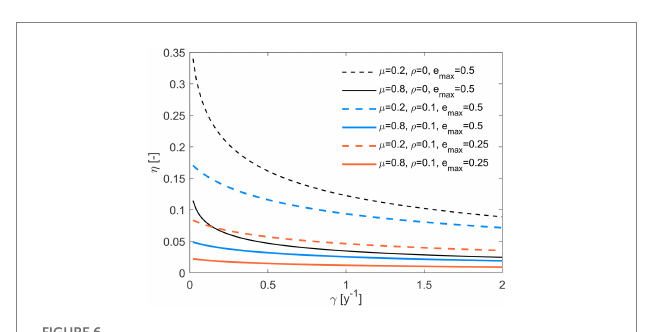
FIGURE 6 Whole system efficiency ( g ) as a function of the C loss rate constant ( g ). Line styles refer to different combinations of the fraction of necromass recycled ( m ), maintenance respiration rate ( r ), and maximum microbial growth efficiency ( max e ). Other parameters: 0 c = 1 g, b= 0.5 g y − 1 . Parameter units are as in Table